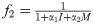
Comparison of media functions.(A) Comparison of media functions in system (1) varying with time, black curve, red curve and blue curve represent f0 = 1, f1 = e−α1I−α2M, f2=11+α1I+α2M, respectively. (B) Comparison of f1 and f2 when parameters α1 and α2 are fixed as values estimated by using Least Square Method and I, M vary.